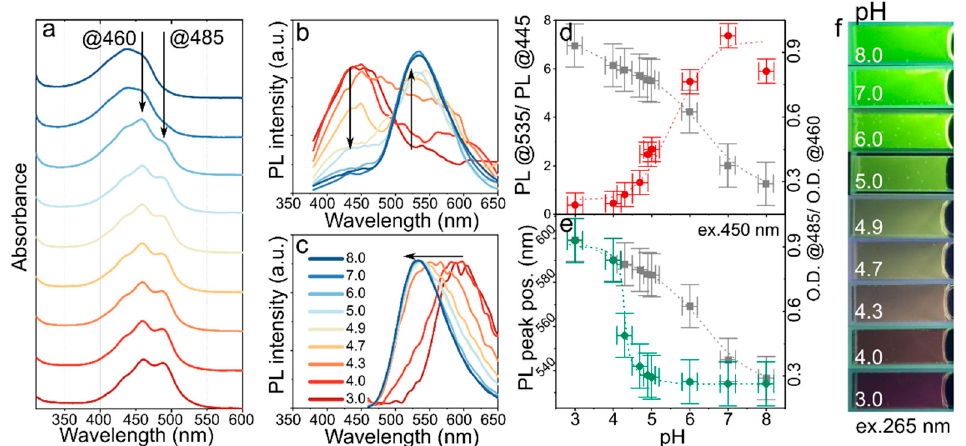
Figure 4. Optical properties of CD-w dissolved in water at different pH. ( a ) Absorption spectra; arrows are used as a guide for eye, ( b ) PL spectra excited at 360 nm; arrows show change in the PL intensity. ( c ) PL spectra excited at 450 nm. Color of lines in ( a – c ) is given in the legend of ( c ). ( d ) Ratio of PL intensities at wavelengths 535 and 445 nm in PL spectrum excited at 360 nm (red diamonds) versus pH value of solution. ( e ) PL peak position under 450 nm excitation (green circles) versus pH value of solution. In ( d , e ), the ratio of optical density at 485 nm to 460 nm is shown by grey squares. ( f ) Photo of CD-w aqueous solutions with different pH under 265 nm